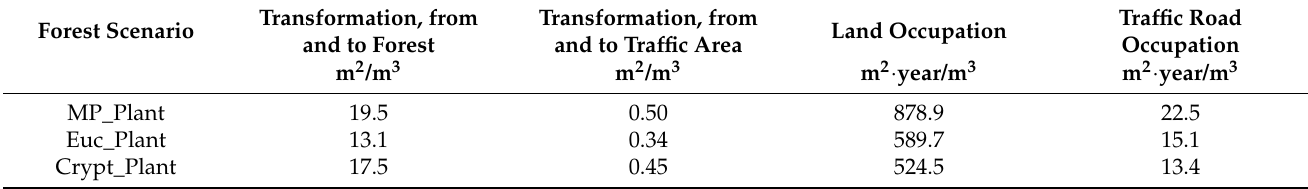
Table 4. Land use inputs of various forest management